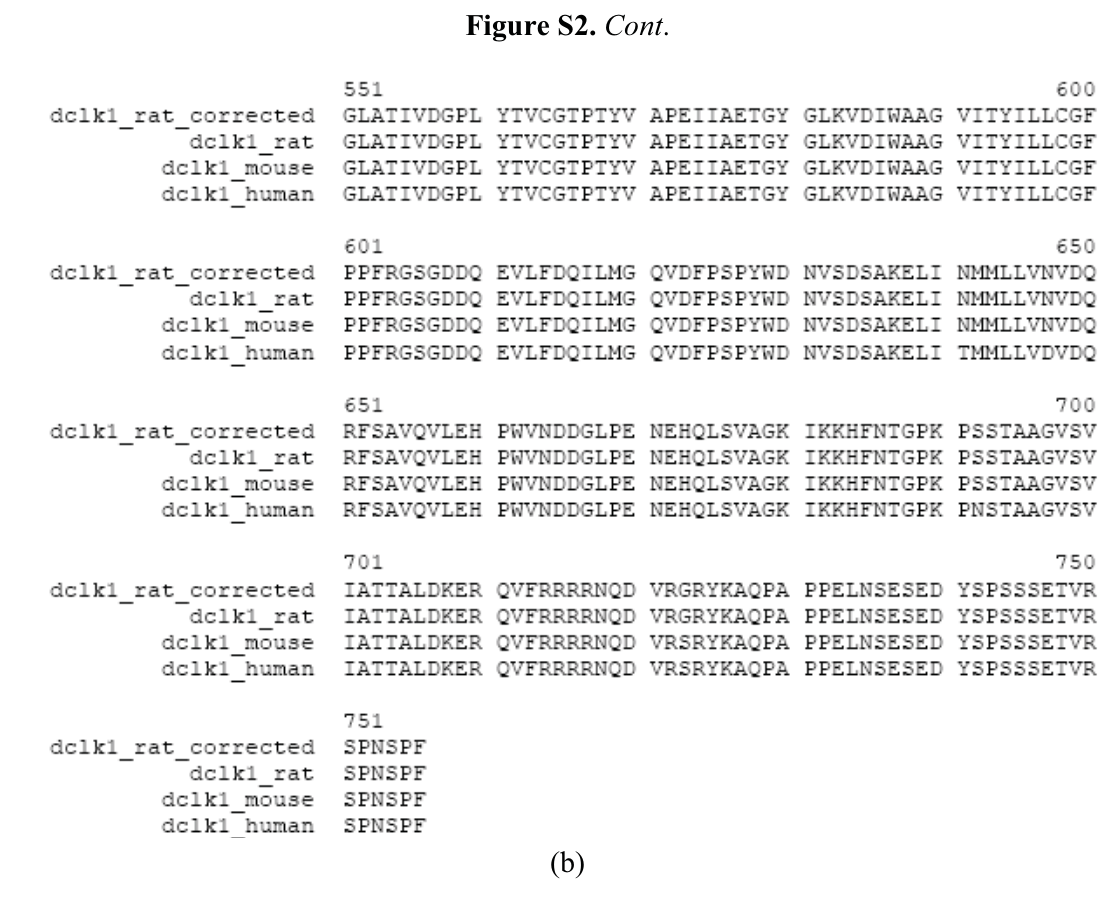
Figure S3. Evidence that SYWM_CAEEL is mispredicted. The Swiss-Prot SYWM_CAEEL sequence arose by in silico fusion of the gene encoding the worm ortholog of PEX10 proteins and the worm ortholog of SYWM proteins. Note that no EST supports the existence of the fusion protein and that separate translation of these genes is supported by EST sequences BJ806113 of Caenorhabditis elegans and EST DR782673 of Caenorhabditis remanei . (a) Alignment of the mispredicted fusion sequence SYWM_CAEEL with its corrected constituents, PEX10_CAEEL and SYWM_CAEEL_CORRECTED; (b). Alignment of the FixPred predicted sequence of worm PEX10_CAEEL with orthologous PEX10 sequences; (c) Alignment of the FixPred corrected sequence SYWM_CAEEL_CORRECTED with orthologous SYWM